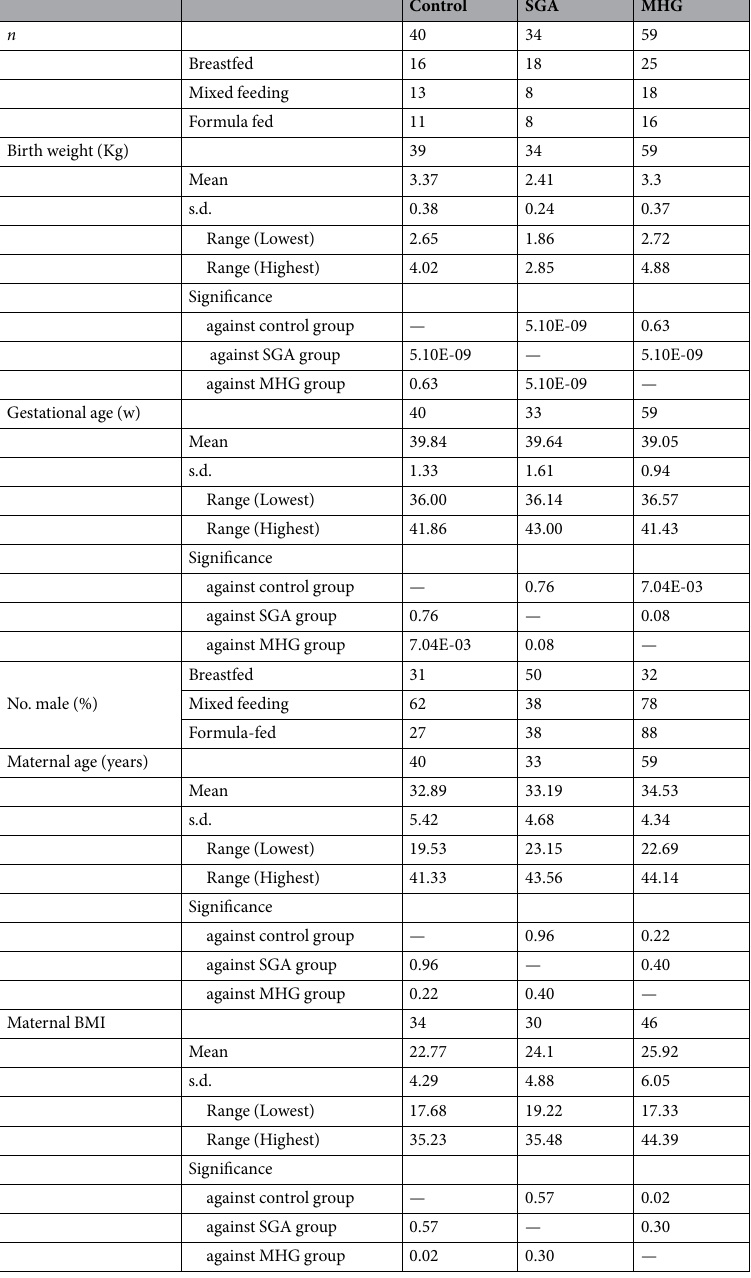
Table 2. Participant characteristics. The characteristics of the participants of the subset if the Cambridge Baby Growth Study II cohort used in this study. n = 133. Significance was calculated using a Tukey HSD post-hoc analysis. Maternal BMI was taken at or before conception. Maternal age is as at